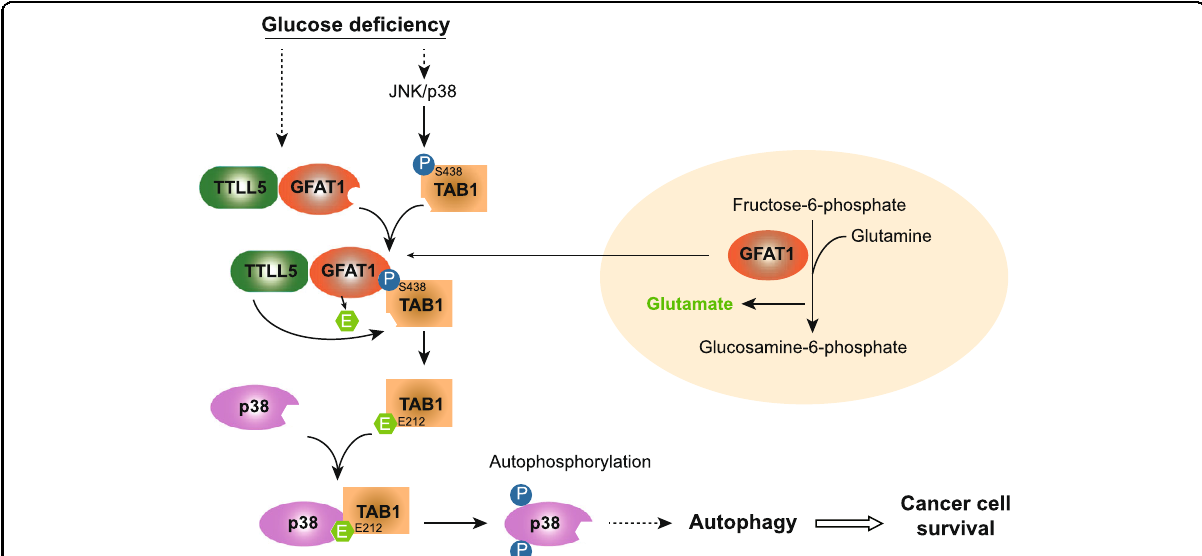
Fig. 7 A mechanism underlying GFAT1-drived cancer cell survival under glucose starvation. A schematic model showing the molecular basis of GFAT1-TAB1-p38 signaling in autophagy-induced cancer cell survival. Glucose de fi ciency promotes TAB1 S438 phosphorylation by JNK/p38 MAPK and subsequent TTLL5 – GFAT1 – TAB1 complex formation. GFAT1-derived glutamate facilitates TAB1 E212 glutamylation through TTLL5, resulting in enhanced TAB1-p38 MAPK interaction and p38 MAPK autophosphorylation. GFAT1-TAB1-p38 MAPK axis sustains cancer cell survival under glucose deprivation via